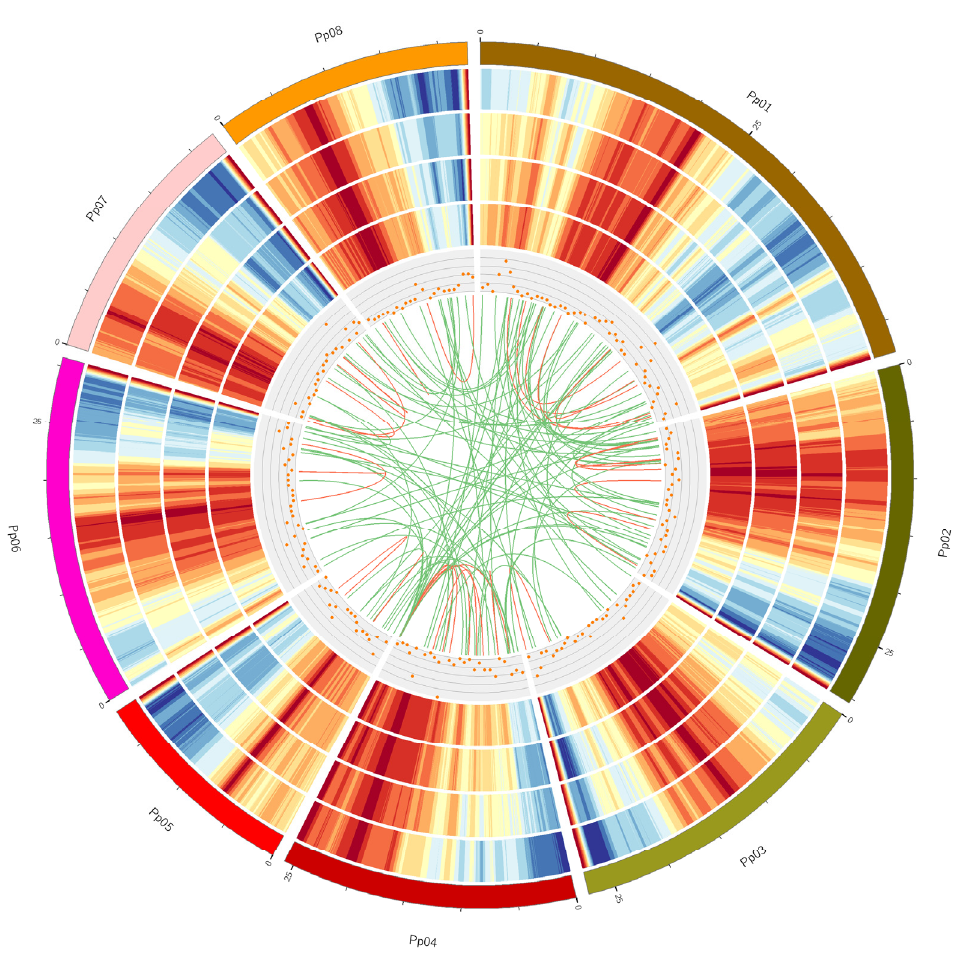
Figure 1. Circos visualization of Prunus persica genome and SMRT Iso-Seq results. Tracks from outside to inside are Karyotype of the Prunus persica chromosome, gene density of the Prunus persica genome, gene density of SMRT Iso-Seq, transcript density of the Prunus persica chromosome, transcript density of SMRT Iso-Seq, long non-coding RNA distribution, and Fusion transcripts distribution. The red and green lines represent the intra-chromosome and inter-chromosome, respectively. The red and blue columns represent the highest and lowest values of gene or transcript density, respectively. The distribution was calculated in a 1-Mb sliding window at 20-kb intervals.